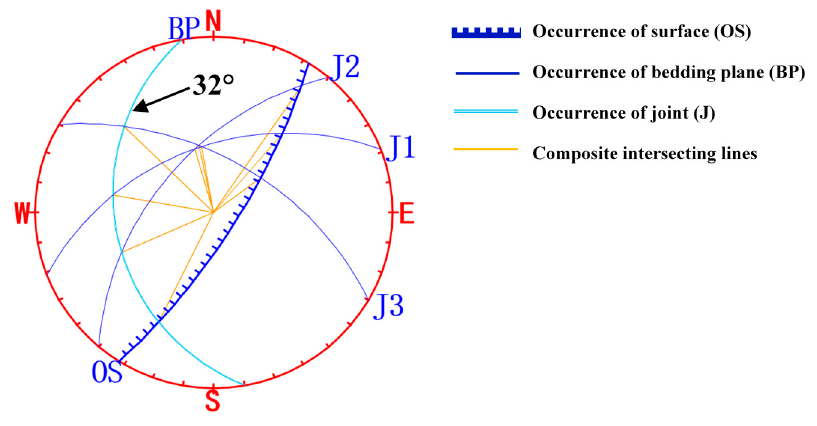
Figure 19. Stereographic projections of the rock slope.